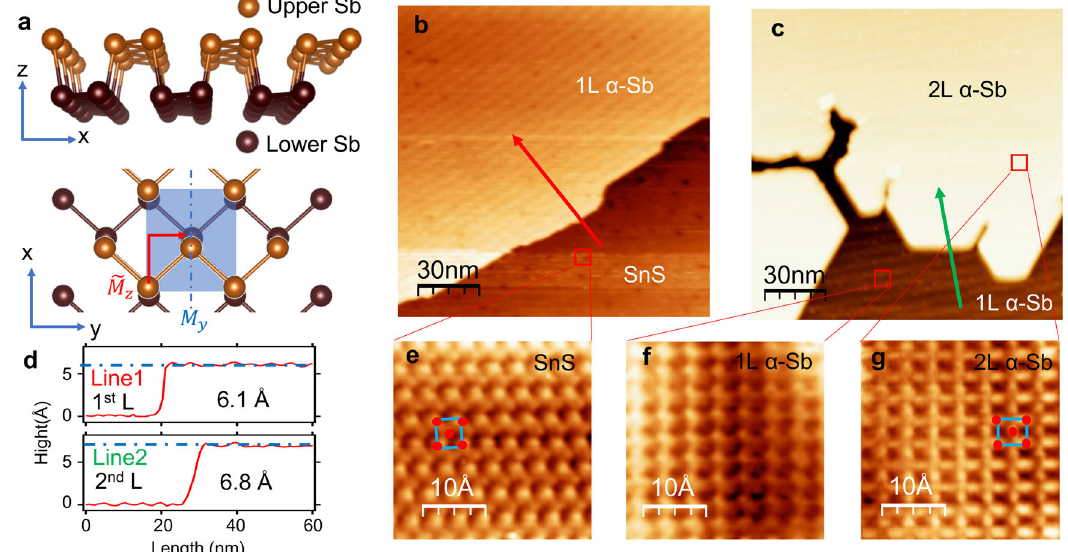
Fig. 1 | Lattice structure and STM characterization of α -Sb fi lms. a Side and top views of α -Sb lattice structure. b STM image of 1L α -Sb grown on SnS substrate. c STM image of 1L and 2L α -Sb domains. d The height pro fi les taken along the red